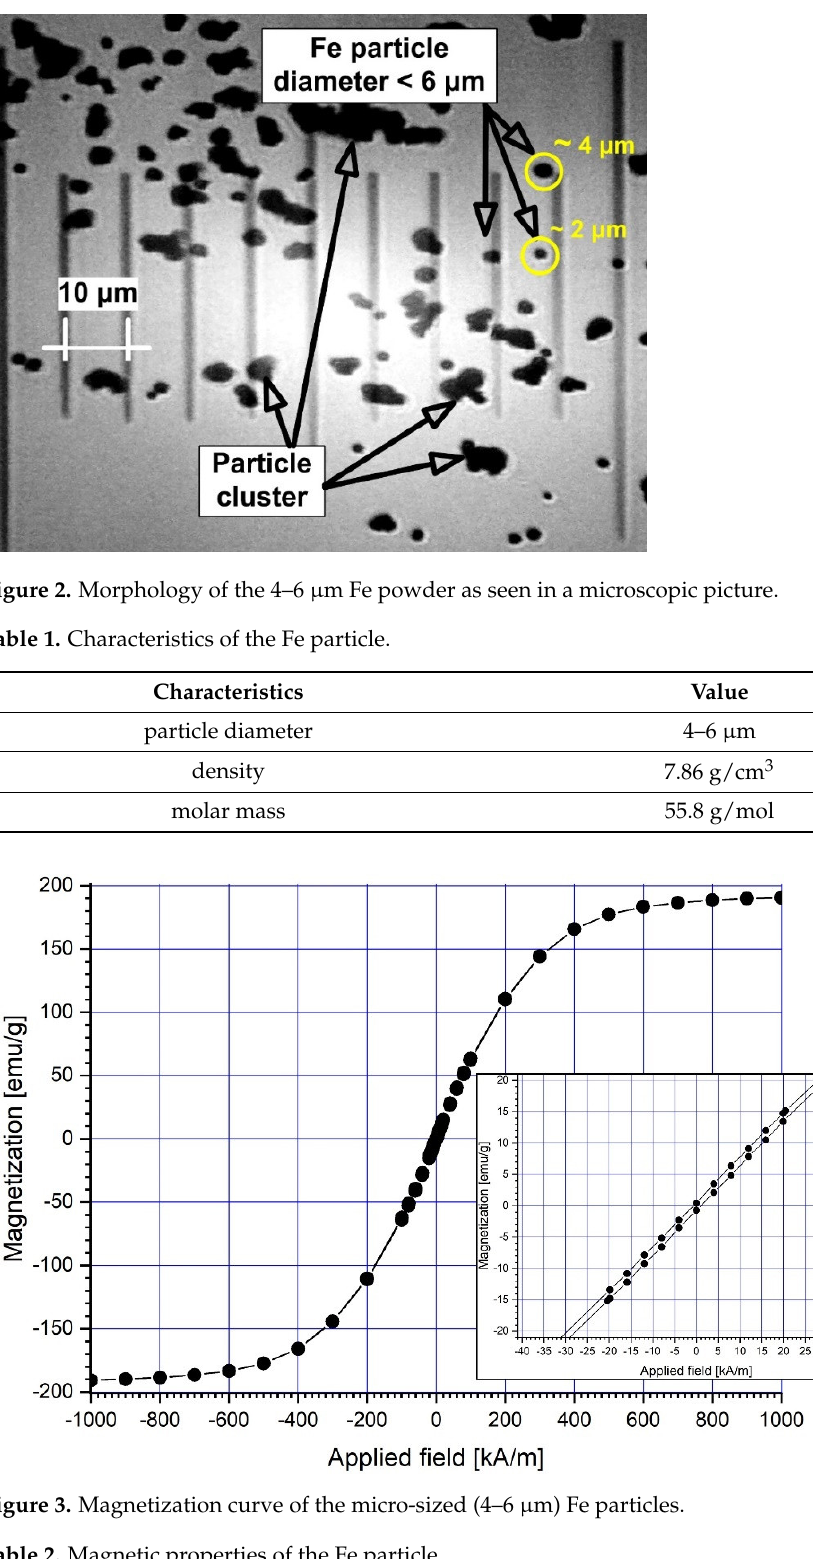
Figure 3. Magnetization curve of the micro-sized (4–6 μm) Fe particles. Table 2. Magnetic properties of the Fe